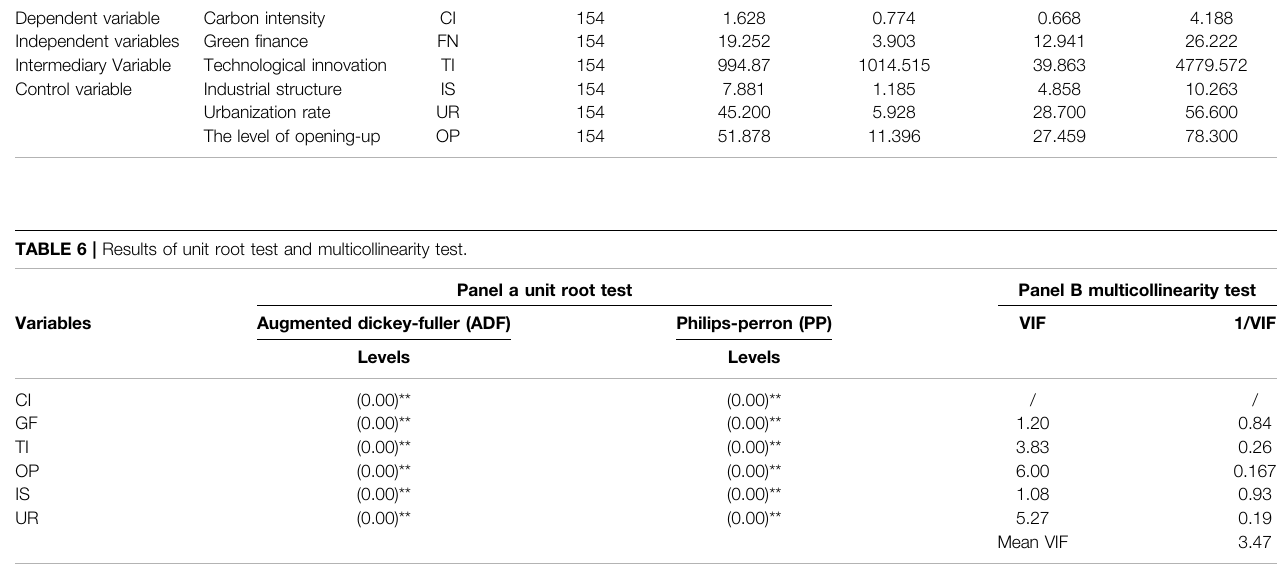
TABLE 5 | Descriptive statistics of the main variables. Variable type